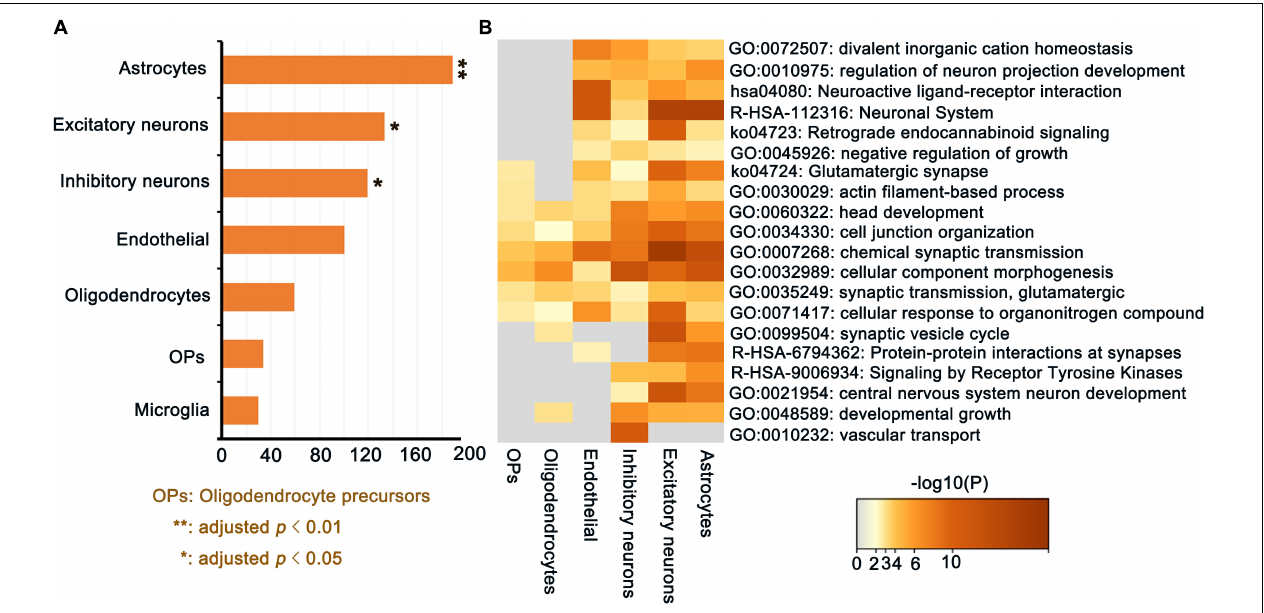
FIGURE 7 | (cid:49) CT-related genes (PLS1) for cell type-specific analysis in discovery dataset. (A) The number of overlapping genes for each cell type (all permutated p -values were adjusted by FDR; (B) Gene Ontology terms enriched for (cid:49) CT related PLS1 genes for each cell